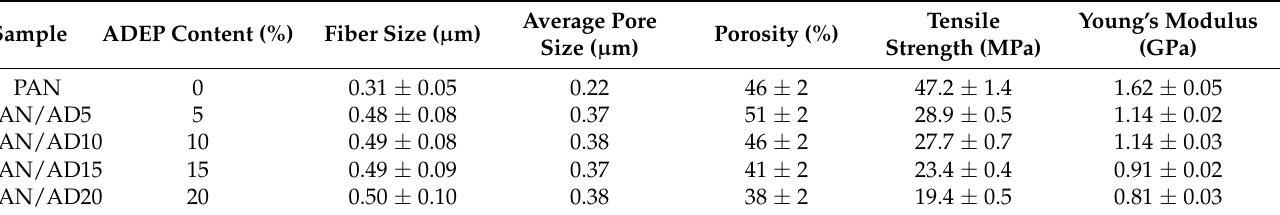
Table 1. The fiber diameter, pore size, porosity, and mechanical properties of the PAN membranes as a function of the content of